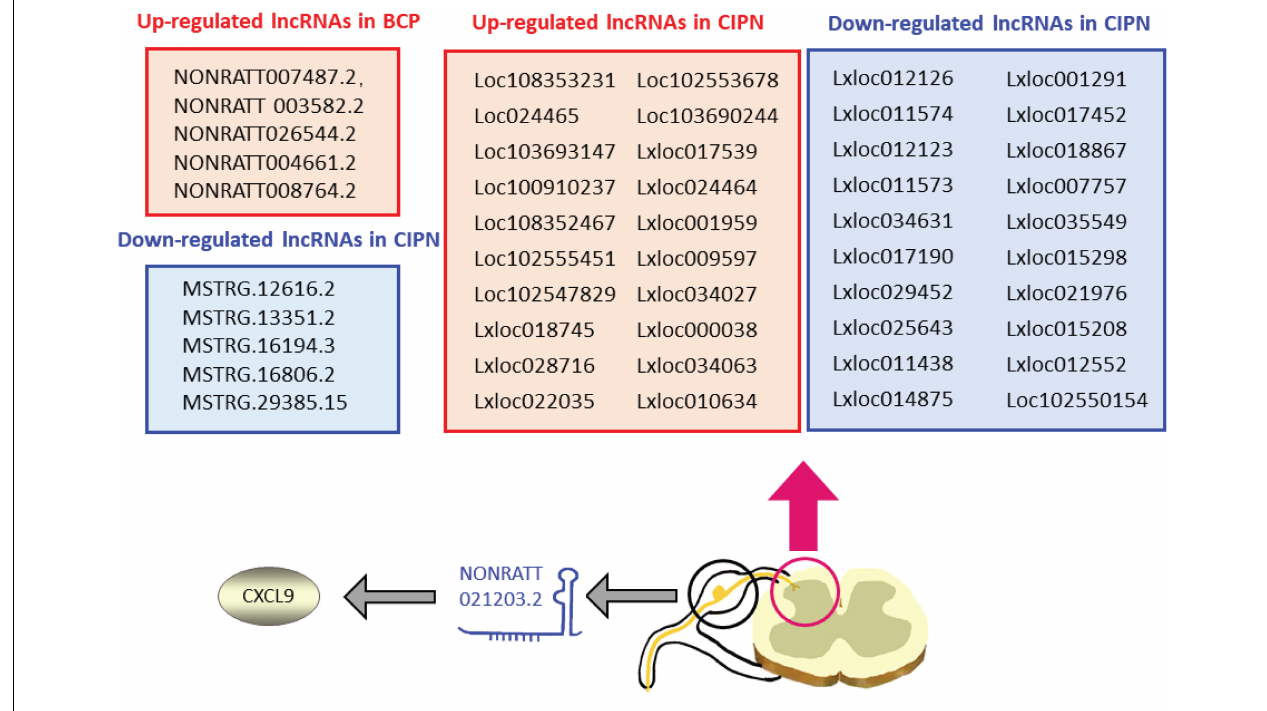
FIGURE 3 | Expression changes and mechanisms of long non-coding RNAs (lncRNAs) in CCRP: many lncRNAs are dysregulated by tumor metastasis and chemotherapy treatment. lncRNA NONRATT021203.2 can exert its effect on BCP by mediating CXCL9 release. BCP, bone cancer pain; CCRP, chronic cancer-related pain; CIPN, chemotherapy-induced peripheral neuropathy.